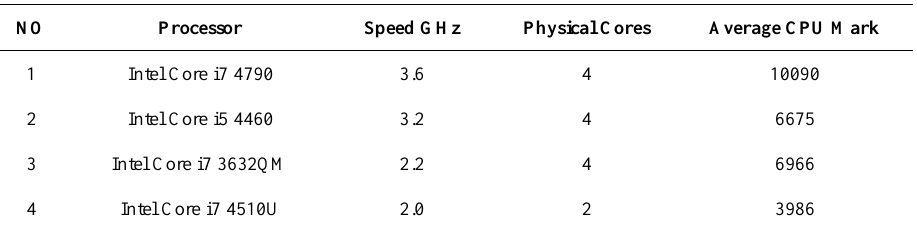
Table 1. Specifictions of proccesors